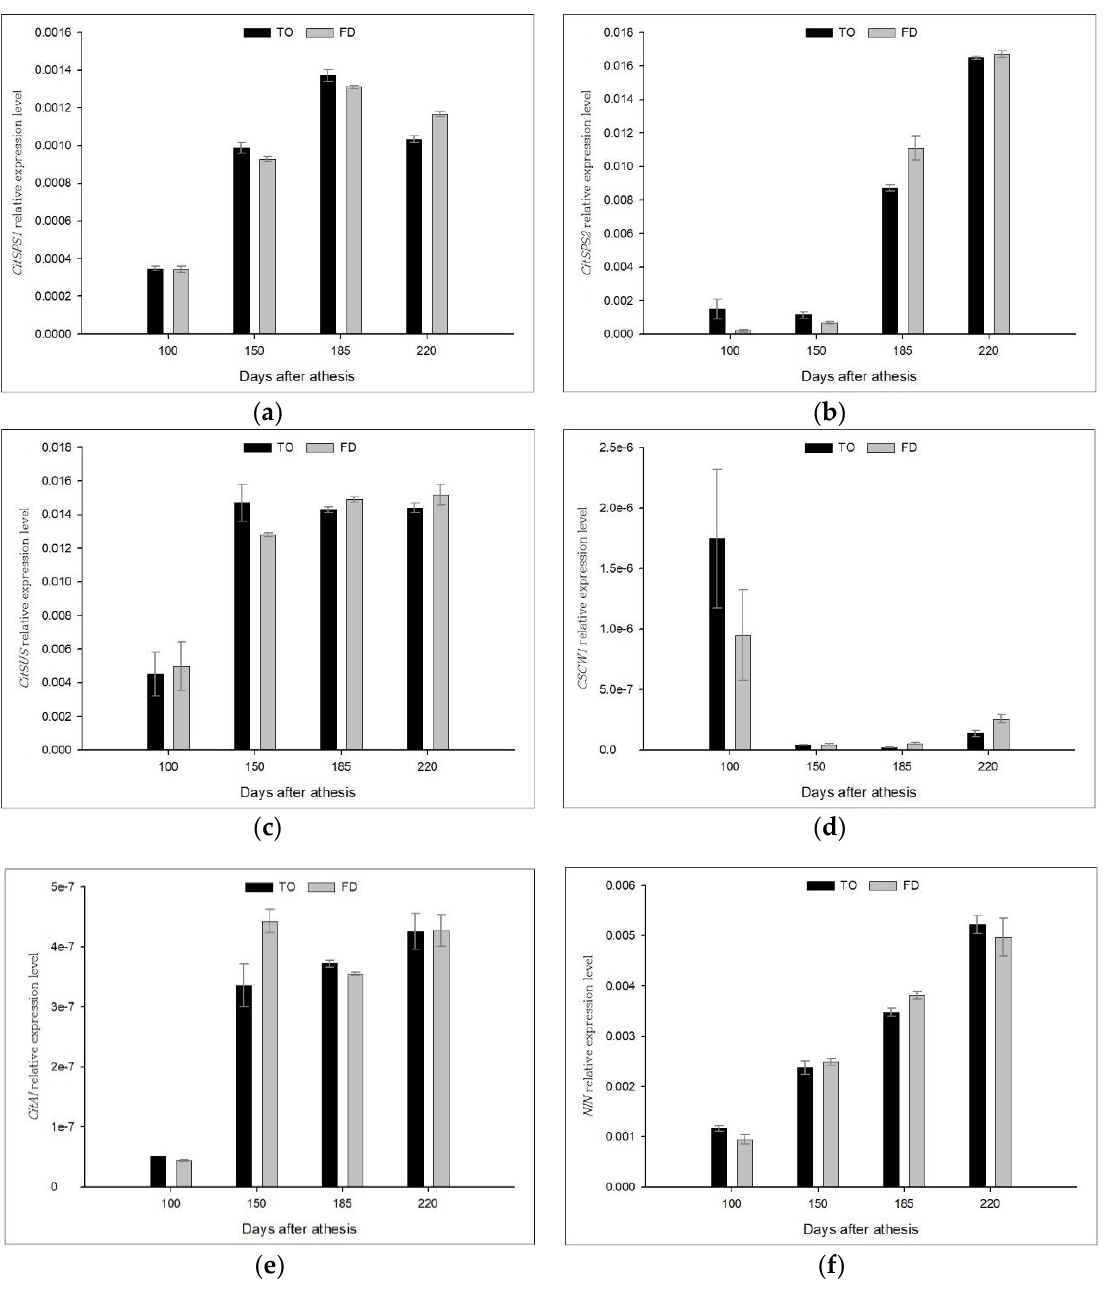
Figure 5. Real-time fluorescence quantitative PCR analysis for the relative expression of sucrose metabolic enzyme genes in the fruits of ‘Minihyang’ grafted on different rootstocks. ( a ) citrus sucrose phosphate synthase 1 ( CitSPS1 ); ( b ) CitSPS2 ; ( c ) citrus sucrose synthase ( CitSUS ); ( d ) Citrus sinensis cell wall invertase ( CSCW1 ); ( e ) citrus acid invertase ( CitAI ); ( f ) neutral invertase ( NIN ).